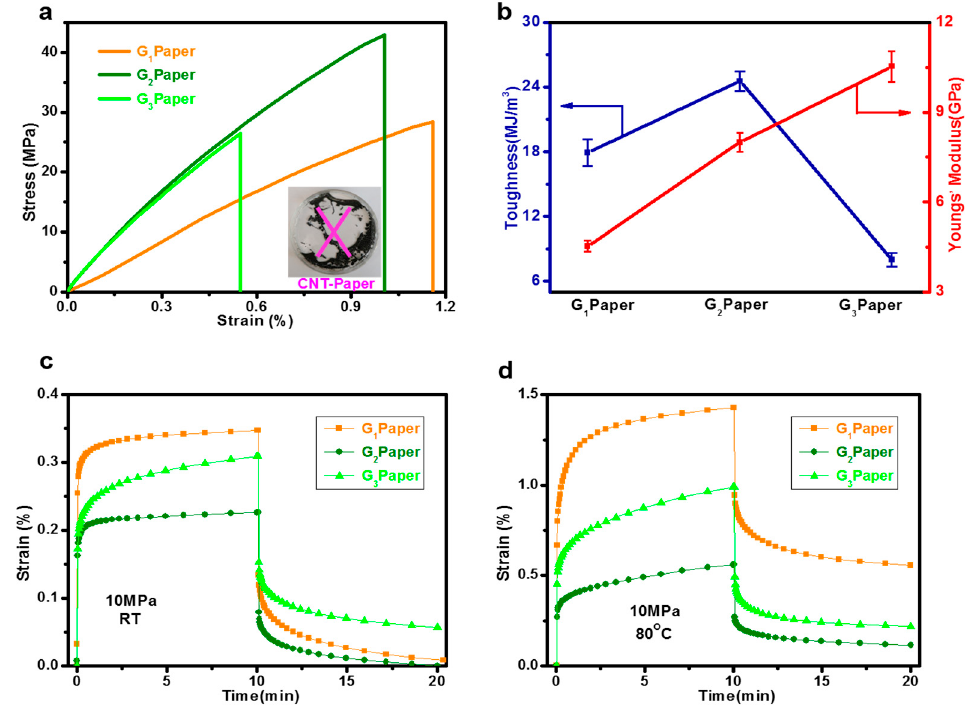
Figure 5. Mechanical properties and creep-recovery of PEG/GONR/MMT nanocomposite papers: ( a ) typical tensile stress-strain curves; ( b ) Young’s modulus and toughness; ( c , d ) creep and recovery curves of PGM papers under R.T. and 80 °C.